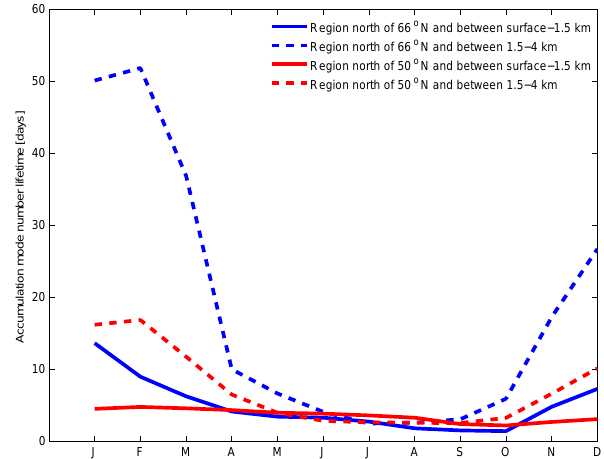
Figure 10. Regional- and monthly-mean aerosol number lifetime with respect to wet deposition for accumulation-mode aerosol num- bers (100 <D p < 1000nm) and in the altitude bands of 0–1.5km and 1.5–4km for the GEOS-Chem simulation NEWSCAV +